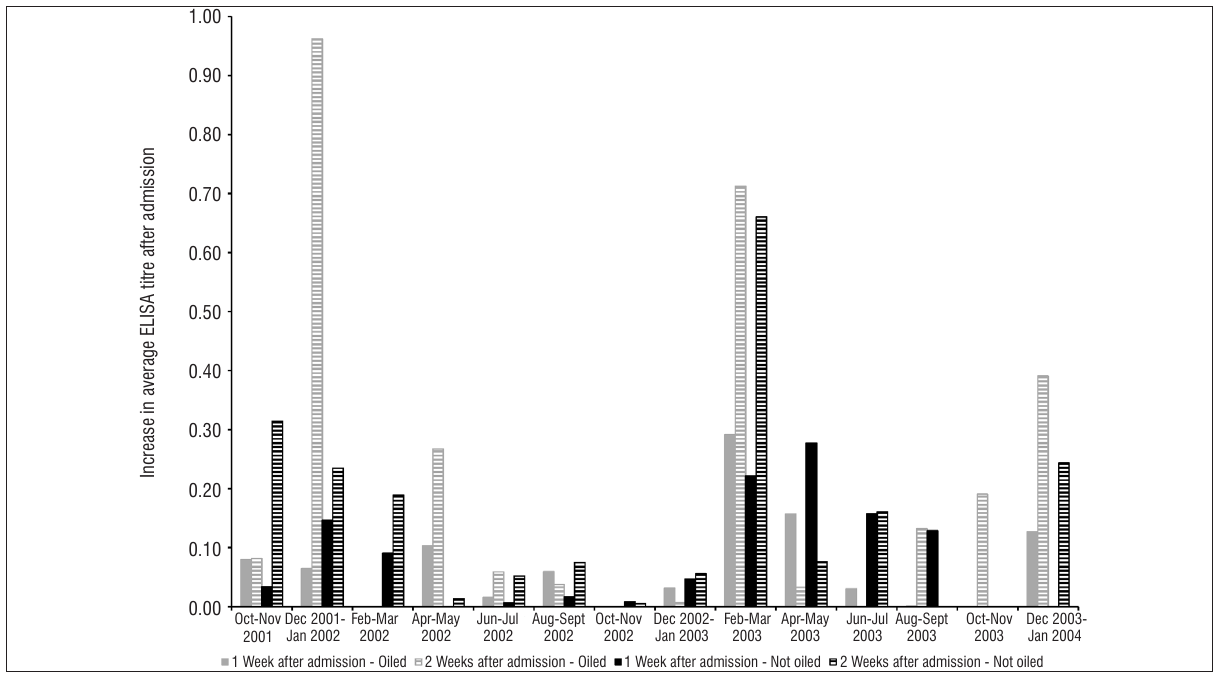
Figure 3: Increases in anti- Plasmodium antibody levels of penguins that were oiled compared with those that were not oiled upon entry into the SANCCOB facility: ‘1 Week after admission’ represents the difference in average ELISA titre values from Week 0 to Week 1; ‘2 Weeks after admission’ represents the difference in average ELISA titre values from Week 0 to Week 2. There were no oiled penguins during February–March 2002. Missing data points for other months reflect no increases in titre values. Avian malaria blood smear data during rehabilitation for African penguins that were oiled and not oiled on